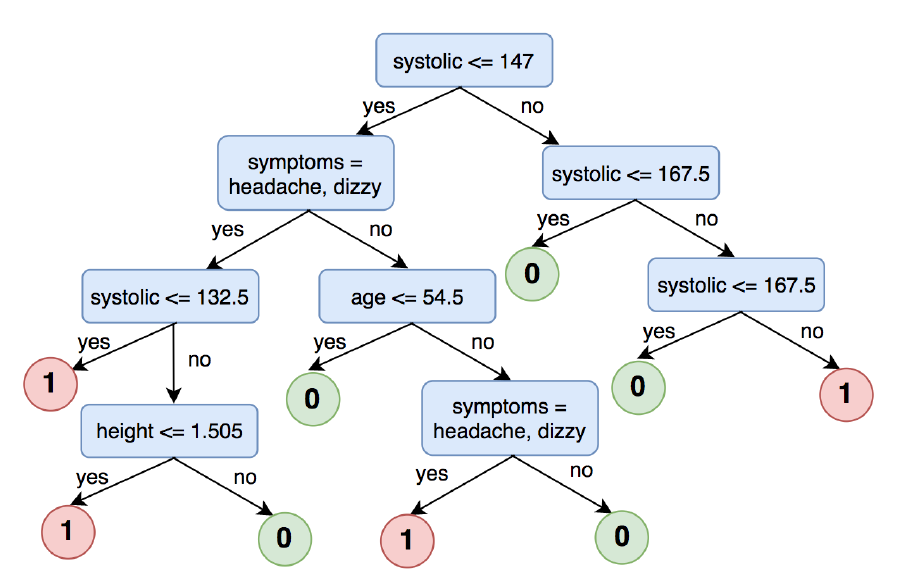
Figure 9. Decision tree of depth 4 for the problem high blood pressure